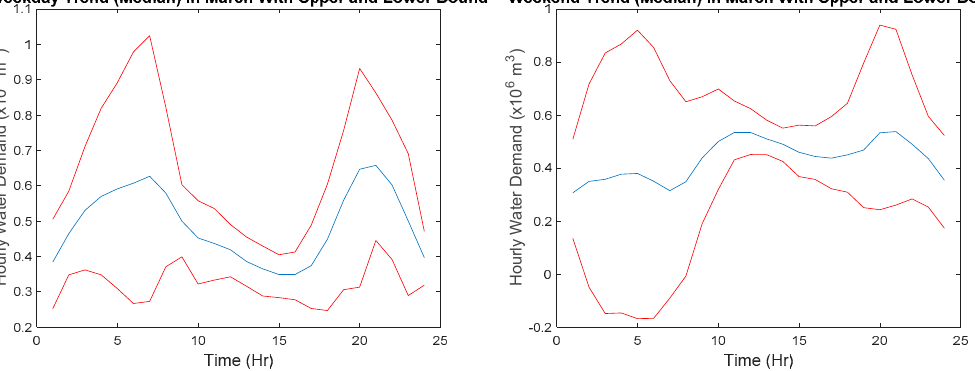
Figure 9. Flowchart of algorithm. 3.4. Rationale As discussed earlier, the proposed approach is meant to carry out all the three objectives, namely to track (1) similarity in time, (2) similarity in the rate of change, and (3) similarity in the shape of the trend. By tracking only the similarity in time or change at a specific hour, it can cause a false negative or a false positive.